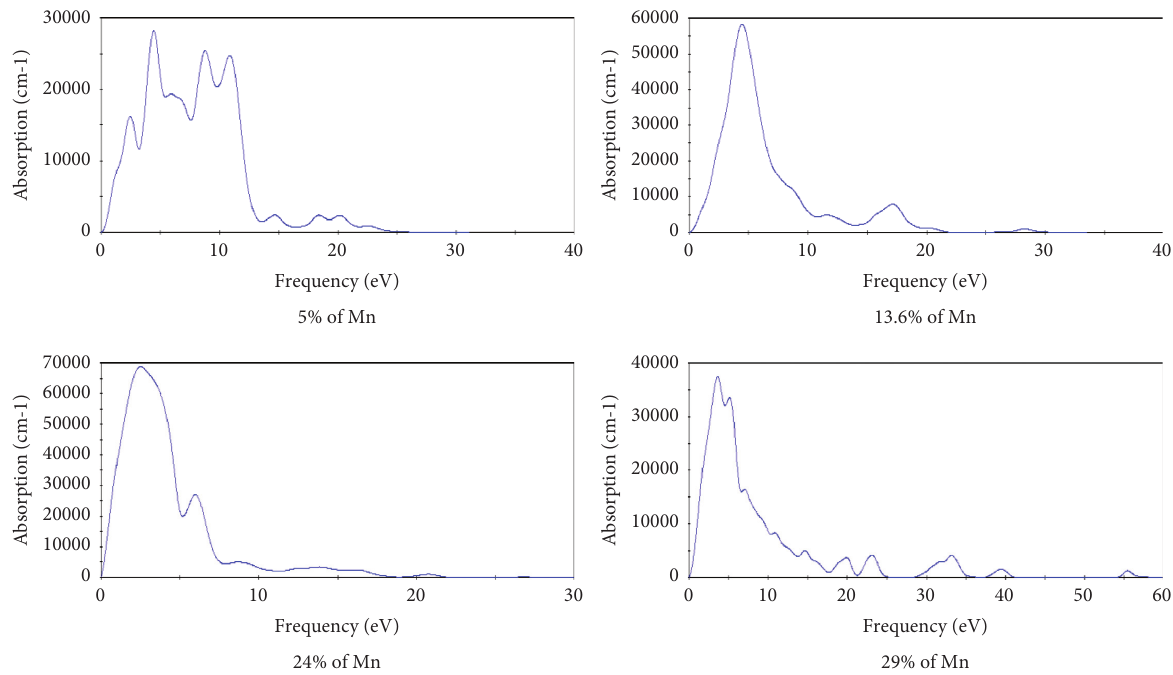
Figure 3: The absorption of InSb–Mn with Mn � 5%, Mn � 13.6%, Mn � 24%, and Mn �